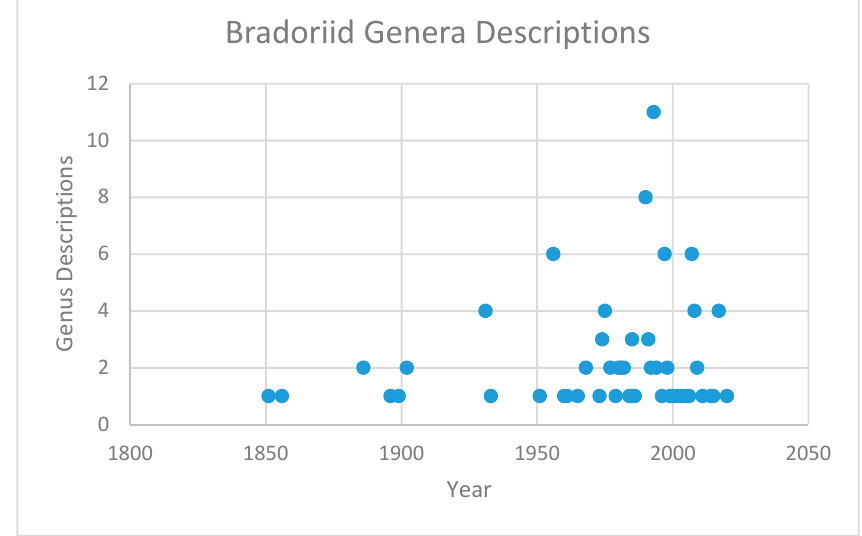
Figure 1. Descriptions of new bradoriid genera by year. Data from “Bradoriid Genera” section below.